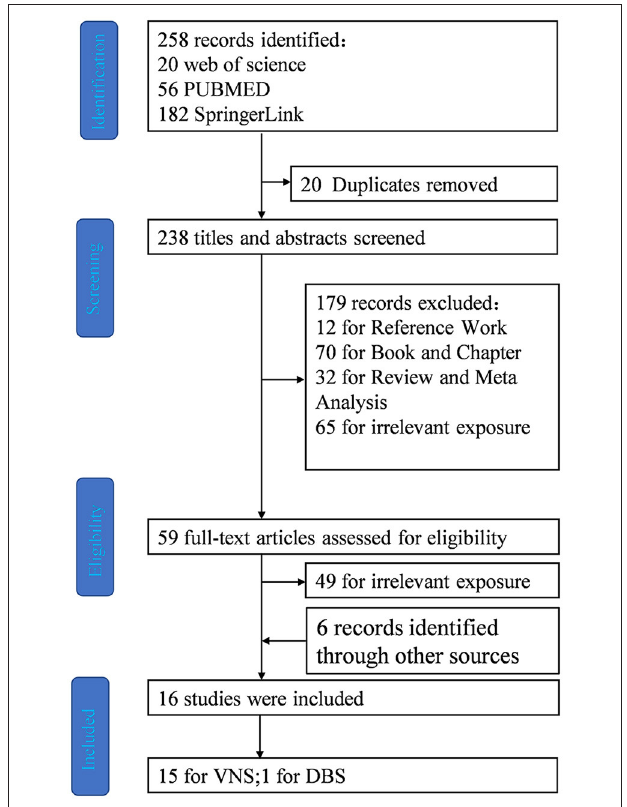
FIGURE 3 | Flow diagram depicting search process and study